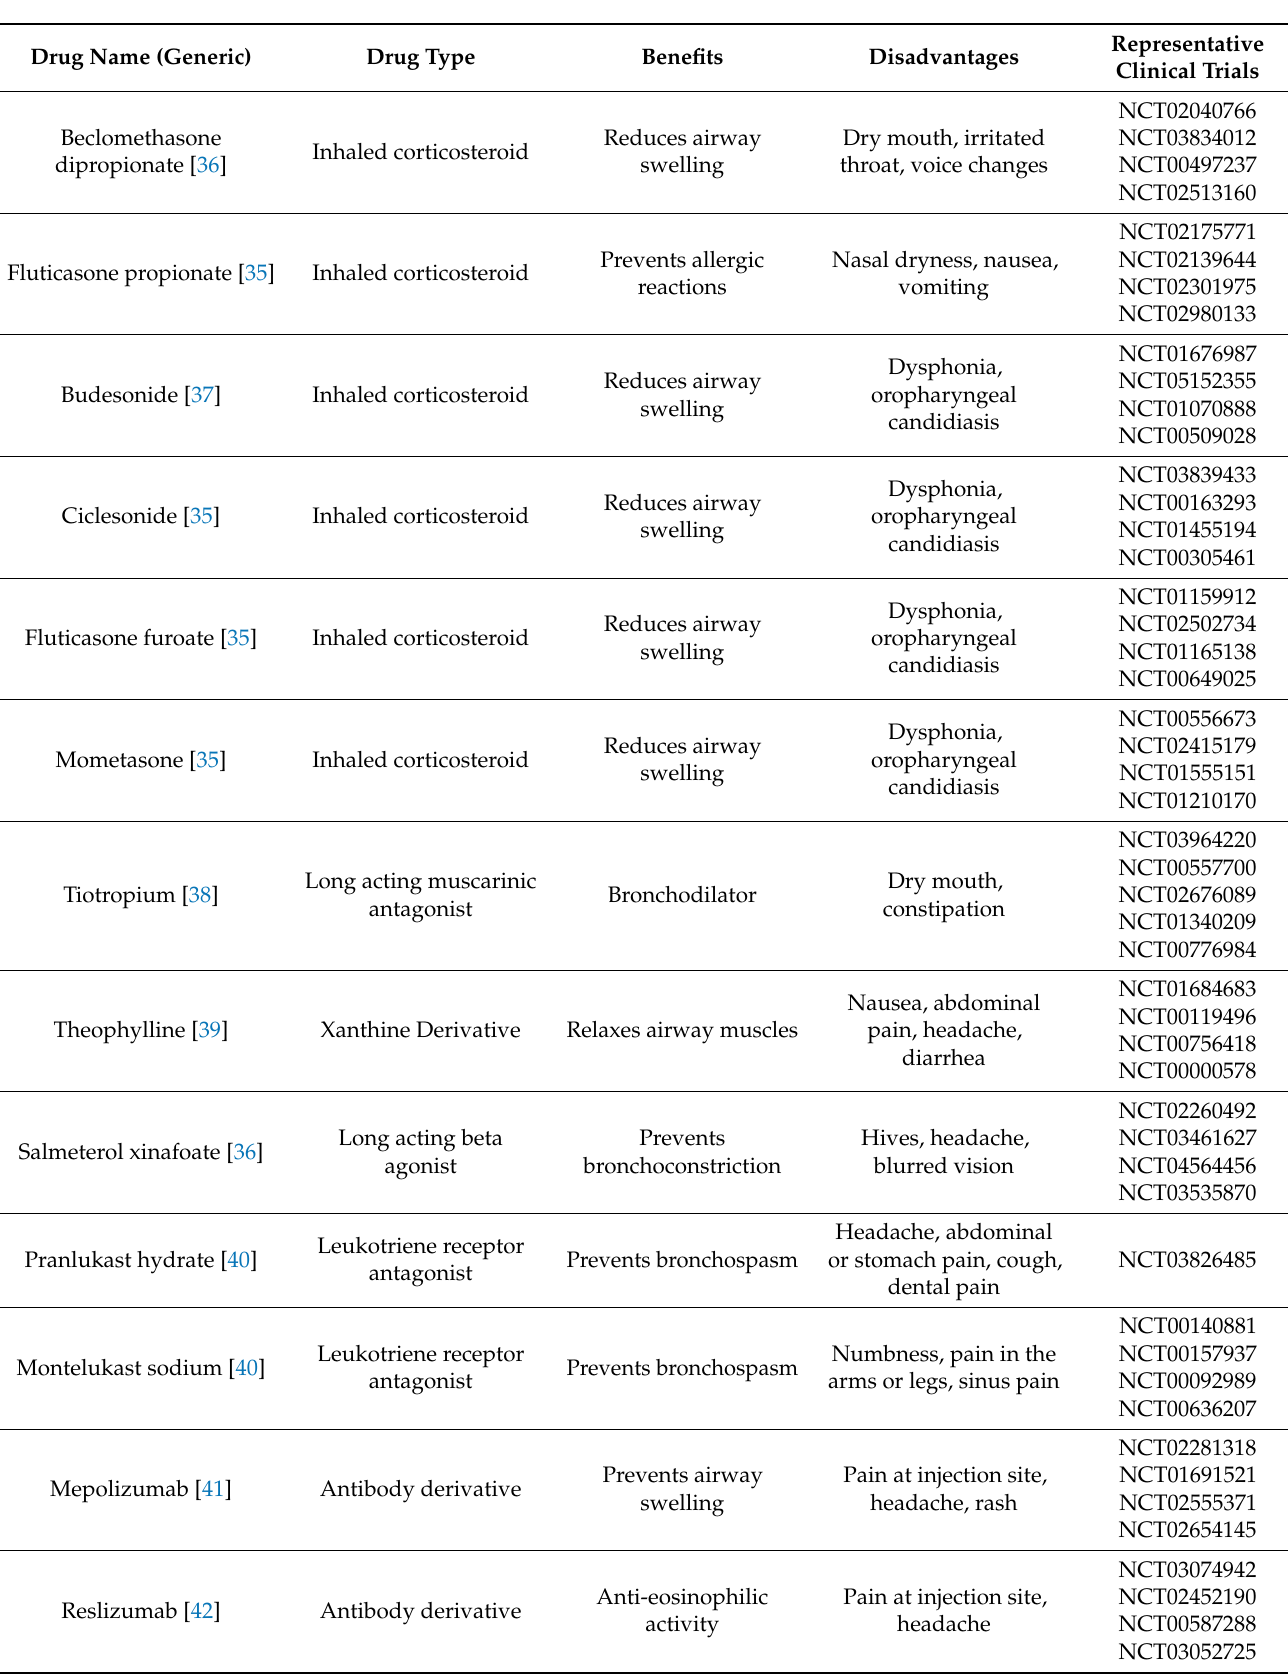
Table 1. Representative Conventional Drugs for